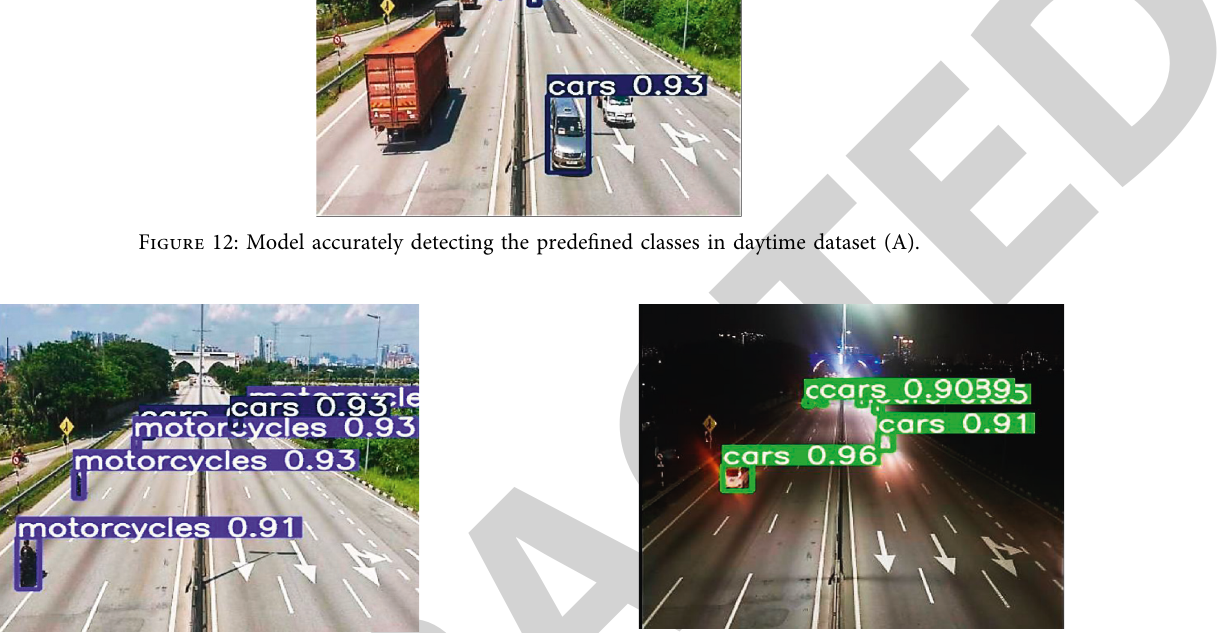
Figure 16: Presence of illumination from headlight.